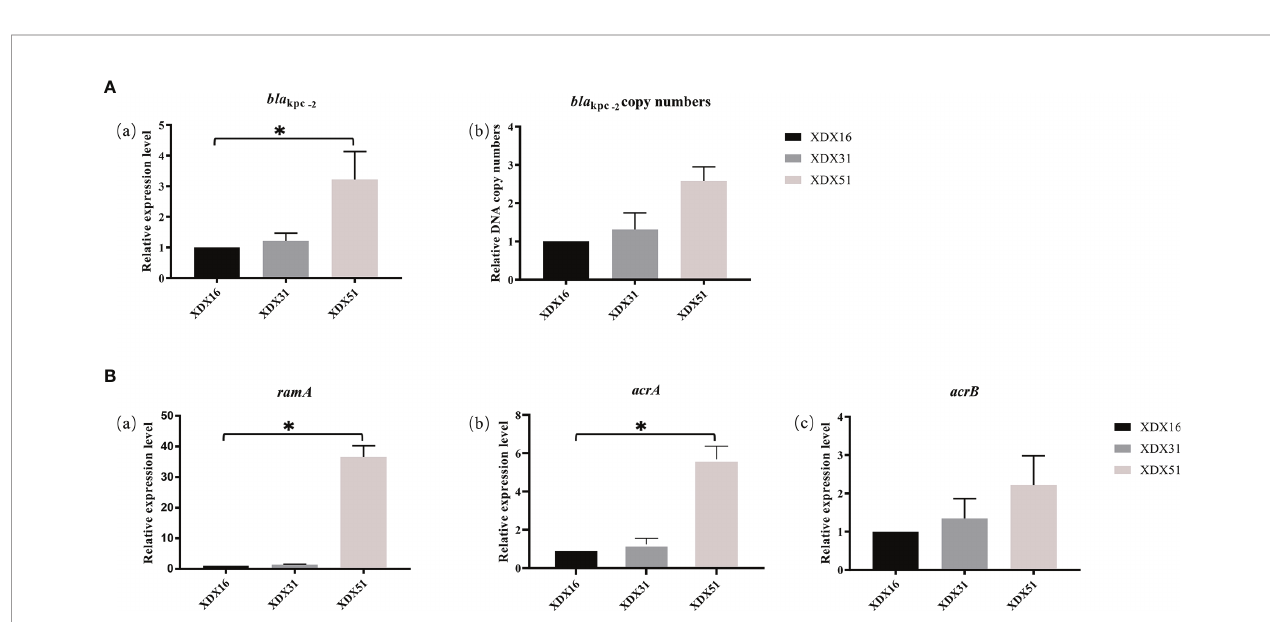
FIGURE 4 | Relative expression level or DNA copy numbers of (A) bla KPC-2- and (B) AcrAB-TolC-related genes. XDX16 was used as the reference strain, and rpoB was used as the reference gene. The bars represent the mean ± standard deviation (SD) of triplicate biological repeats; the mean differences in log 2 fold change were analyzed using an unpaired t test. * p <